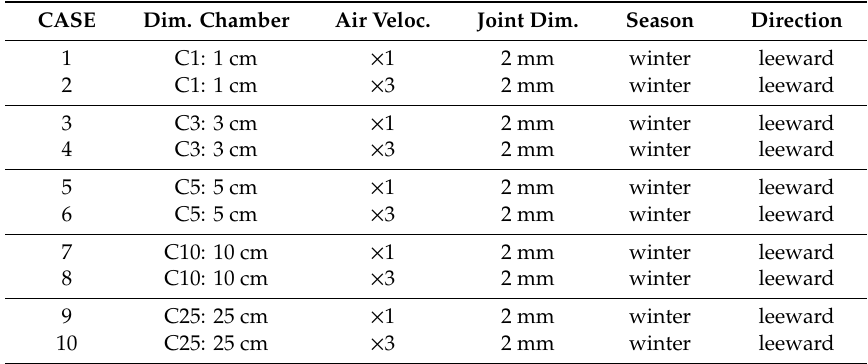
Table 1. Parameters established for the cases